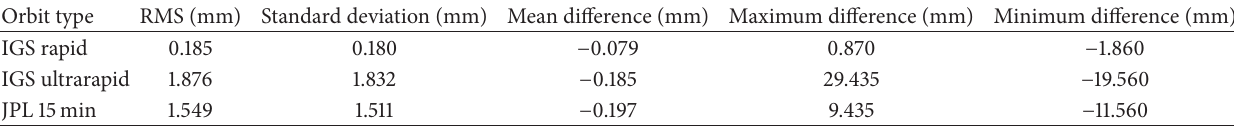
Table 3: Comparison of ZTD estimation using different orbit products (the ZTD estimates obtained using IGS final orbits were used as reference to compute the other result) (after